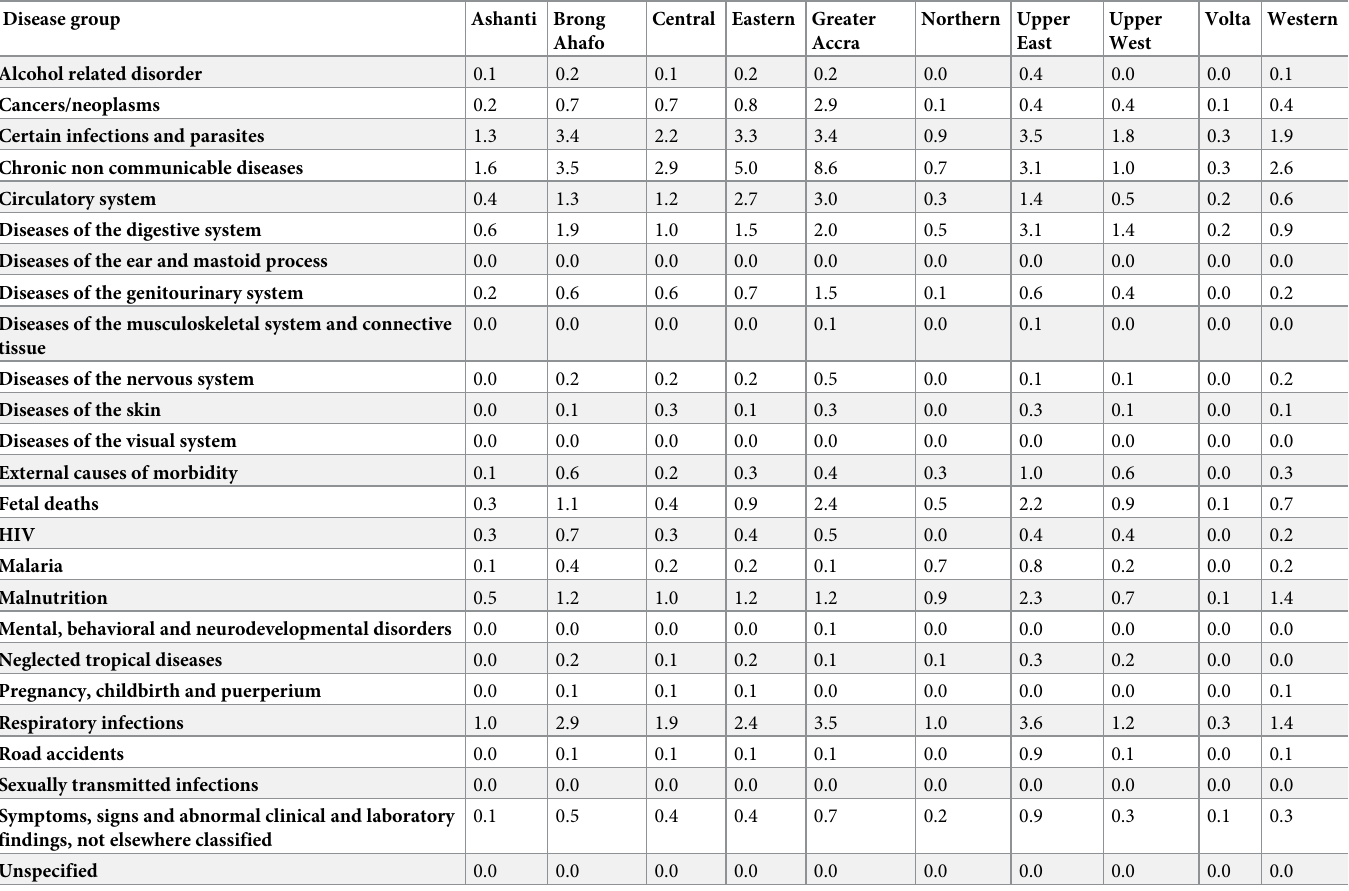
Table 4. Mortality rate by disease groups in 2018 at health facilities in Ghana, by